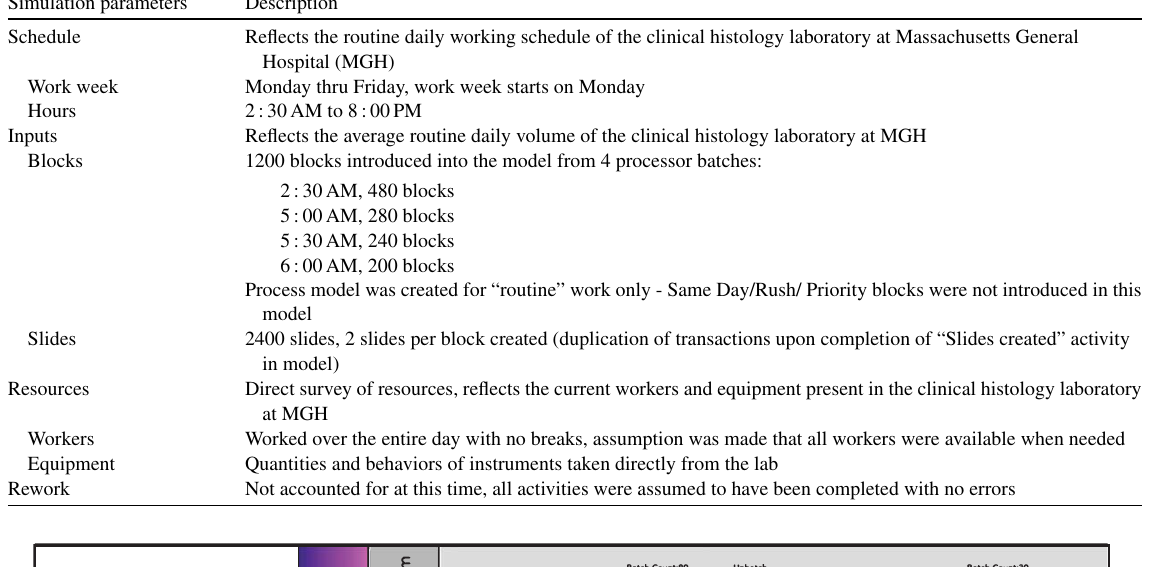
Simulation parameters used for the baseline clinical histology laboratory and the WSI robot process models